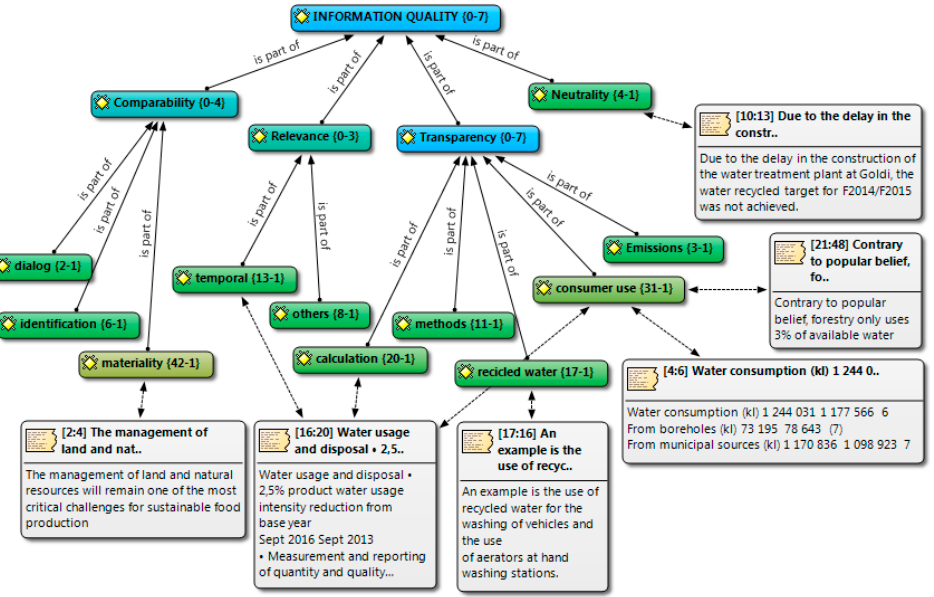
Figure 5. Information quality ( Source: Own work). Water 2017 , 9 , 830